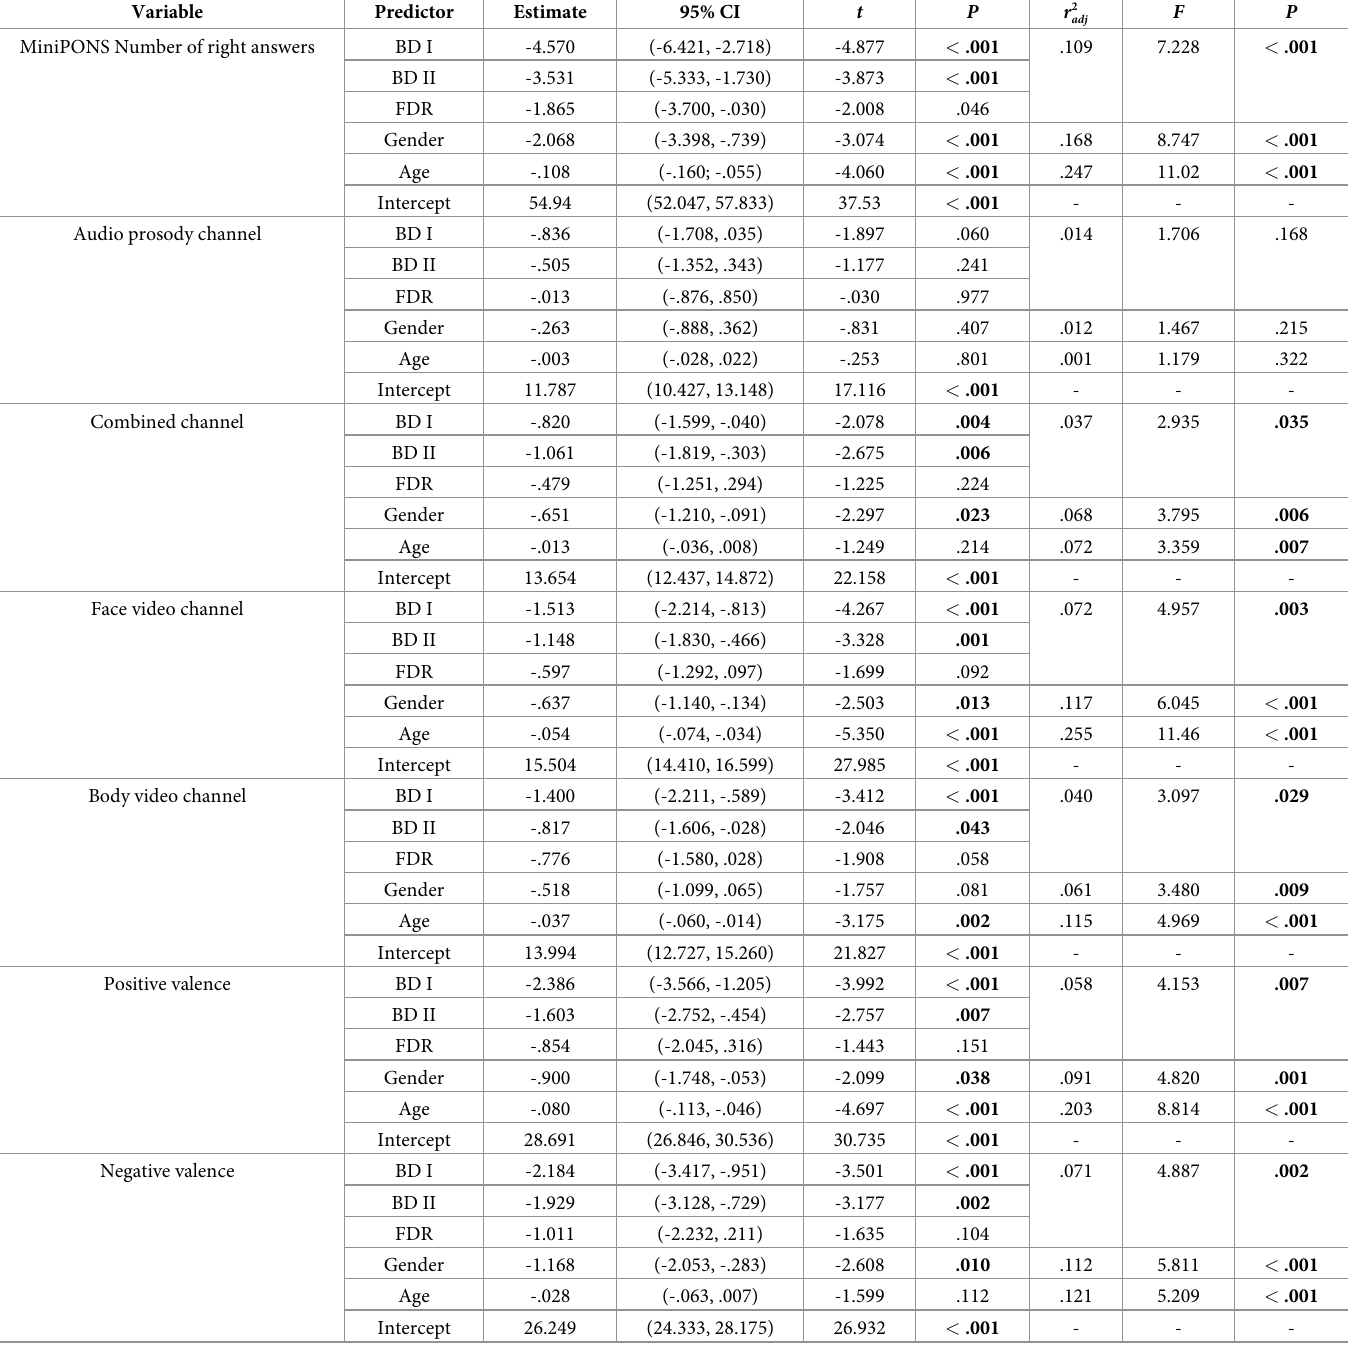
Table 3. Multiple linear regression in the prediction of the performance in MiniPONS and RMET